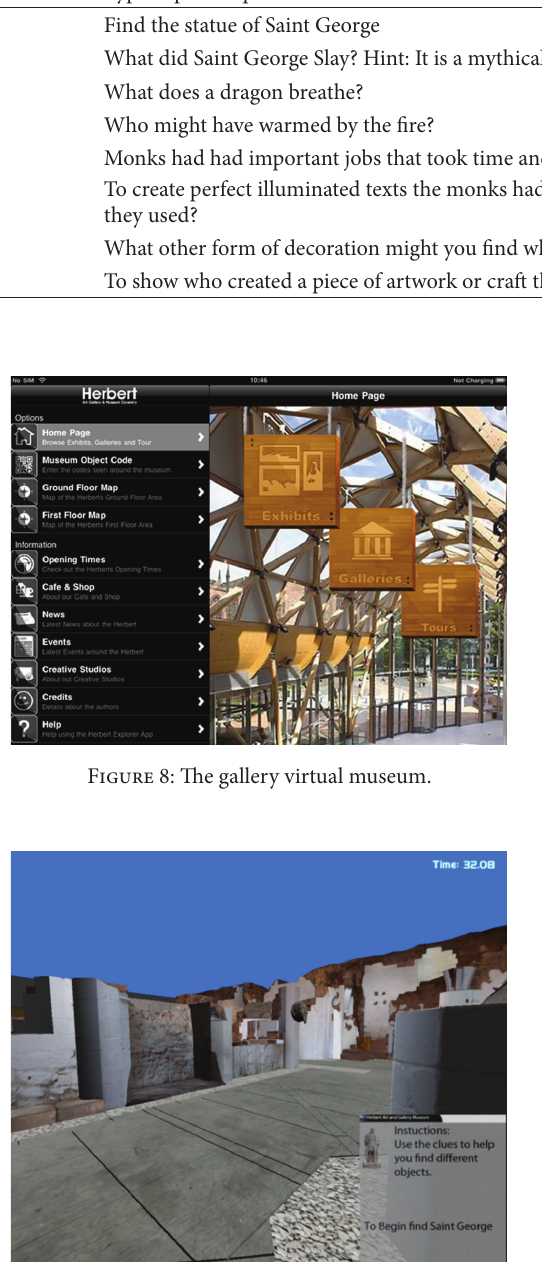
Figure 9: Priory undercroft